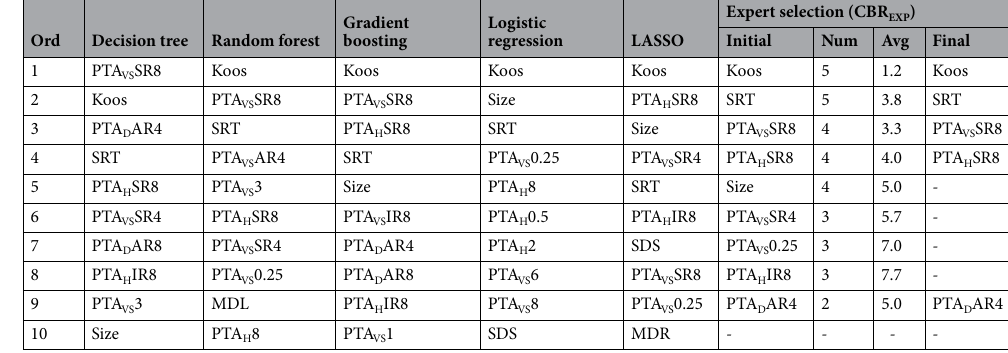
Table 1. Predictors, extracted from CBR data, ordered according to their significance for applied dimensionality reduction method. Irrelevant variables were rejected from expert selection. Variables and metrics are expressed as follows (see “Methods”): (a) suffix 4 holds for the basic frequency range, suffix 8 holds for the full frequency range; (b) subscripts H and VS hold for the healthy or diseased ear, respectively, subscript D holds for the difference of averaged PTA values between the two ears; (c) tailing abbreviations have the following meaning: AR average row wise, IR intercept row wise, SR slope row wise.